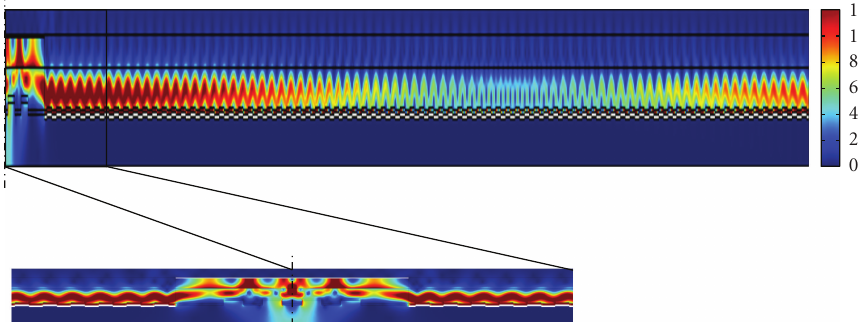
Figure 5: Power flow after introducing an optimized waveguide cavity. The aspect ratio of the lower picture is accurate, but the upper picture was stretched vertically by 2x for visibility. The color scale is power flow divided by incident power per unit area. Parameters used for this field plot: grating parameters same as above, w cap = 26 . 2 μ m, Λ C = 4 . 4 μ m, d C = 500nm, t ZnSe,1 = 1 . 1 μ m, t cap = 100nm, N C = 4, λ 0 = 11 μ